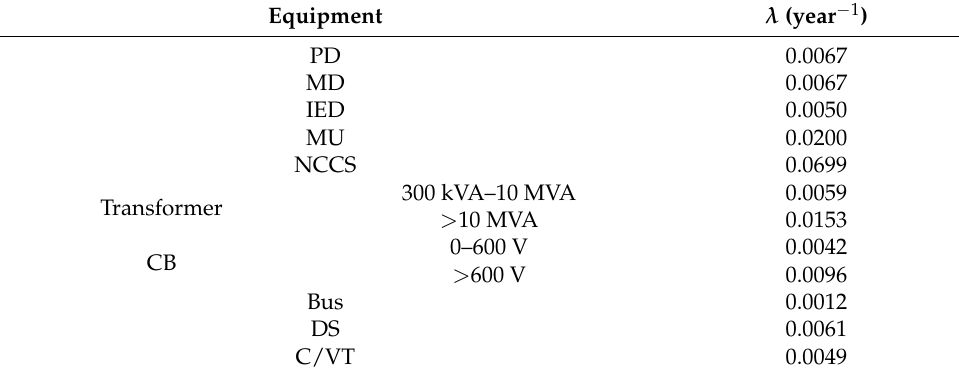
Table 4. Reliability data of equipment.